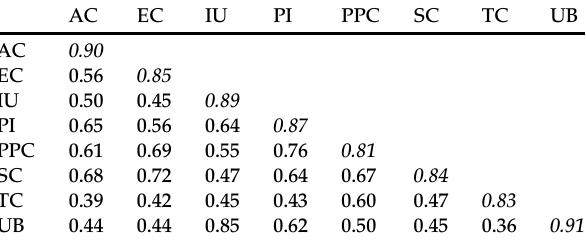
Table 3. Assessment of discriminant validity (Fornell-Larcker criterion).